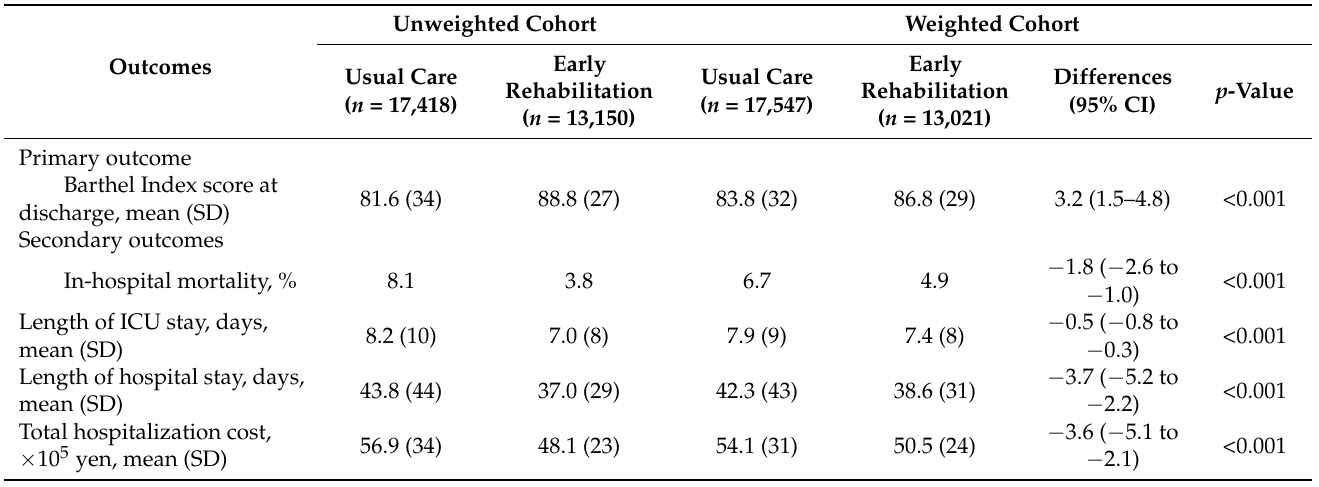
Table 2. Outcomes in the unweighted and weighted cohorts using inverse probability of treatment weighting analyses.